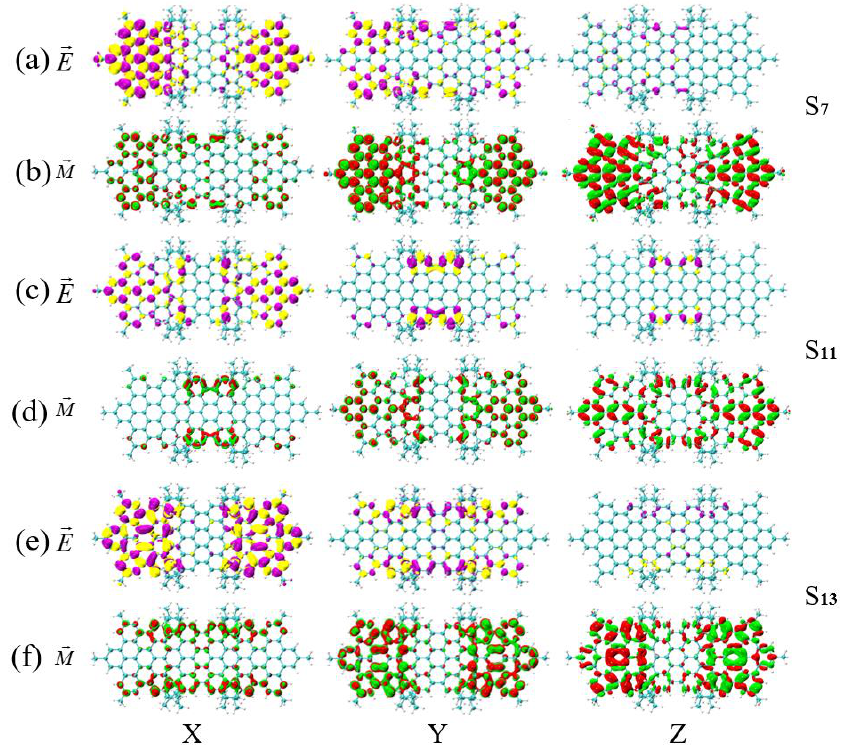
Figure 9. The TEDM and TMDM of S7, S11 and S13 of symmetrical diastereomers (PMPM). ( a , b ) are the TEDM and TMDM of S7 in the x/y/z direction; ( c , d ) are the TEDM and TMDM of S11 in the x/y/z direction; ( e , f ) are the TEDM and TMDM of S13 in the x/y/z direction. The letters E and M in the figure indicate the TEDM and TMDM of the molecule, respectively.